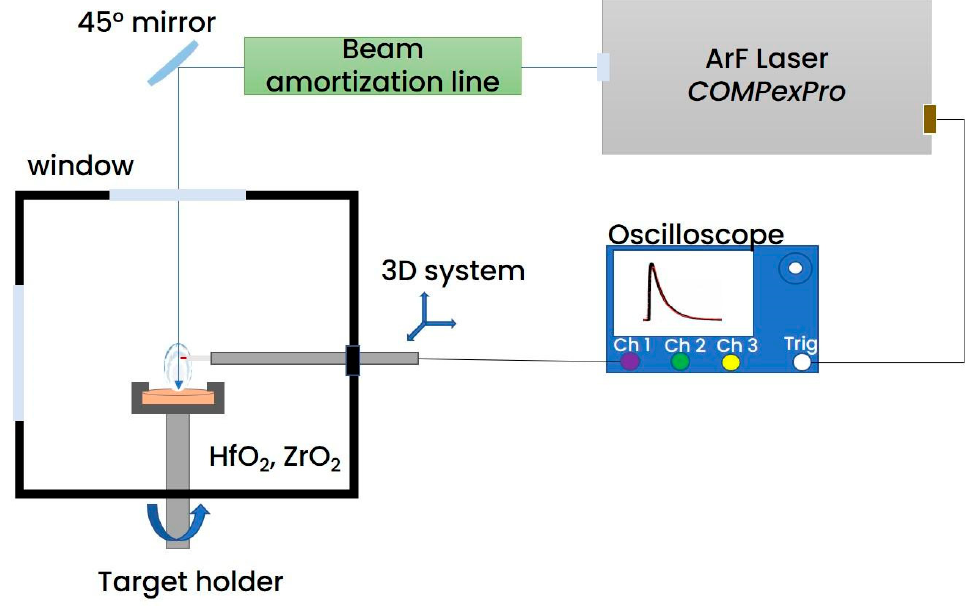
Figure 1. Experimental set-up for the LP measurements.